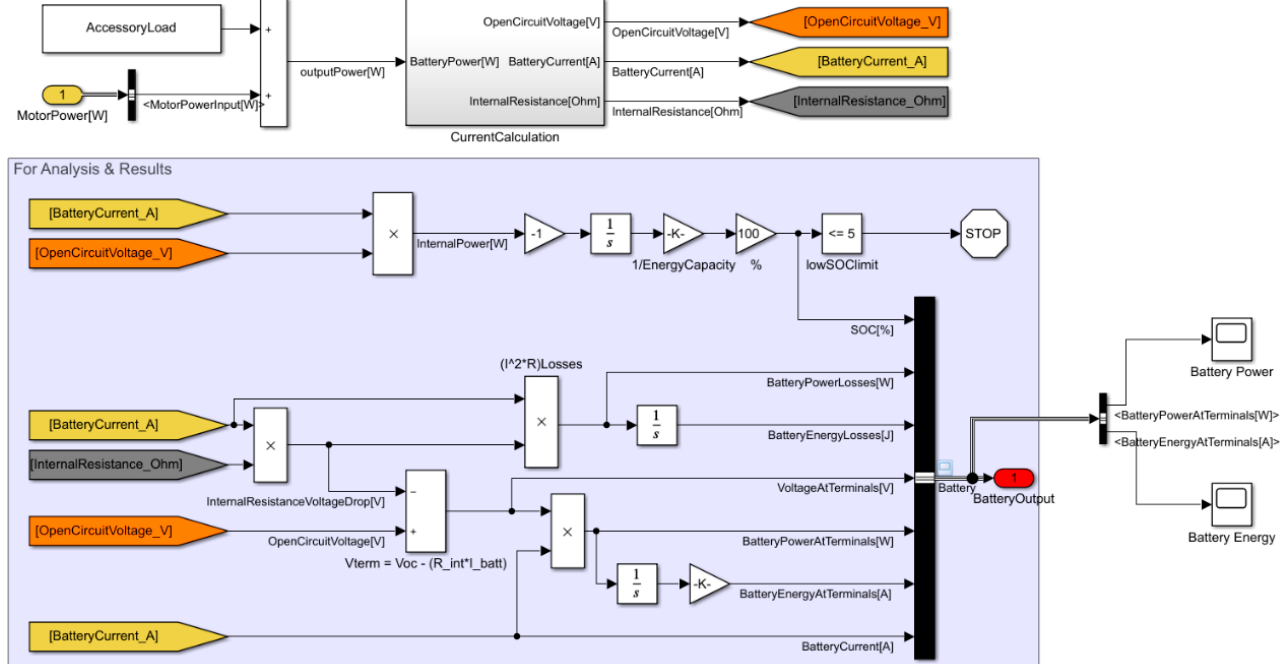
Figure 13. Battery model with SOC and power loss calculations. Adapted from [16], MathWorks: 2020.